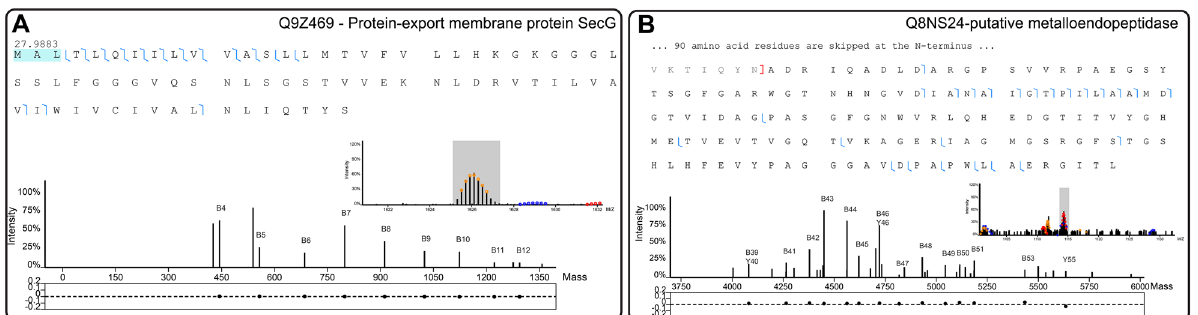
Figure 4. PrSMs of Protein-export membrane protein SecG (Q9Z469) and putative metalloendopeptidase mepB (Q8NS24). In the top region of both images (A and B) can be seen the sequence of the identified protein, where possible sites of the Δm are represented by residues highlighted in blue background and matched fragments are represented by blue lines between amino acid residues. In the bottom region, the MS1 and isolation window of the identified precursor are depicted (right side of each figure) as well as the mass representation of the MS2 spectrum attached to the mass error of matched fragments. ( A ) Inspection of the 28 Da mass shift identified in SecG, where we could see that 12 fragments (all b -ions) support the identification of the 27.9883 mass shift near the N-terminal. The mass error of great part of these fragments were close to 0 ppm, as depicted in the bottom of the image. ( B ) Inspection of mepB cleaved proteoform (cleavage site represented by the red bracket), which demonstrates a great number of fragments supporting the cleaved proteoform (all b -ions) with mass error close to 0